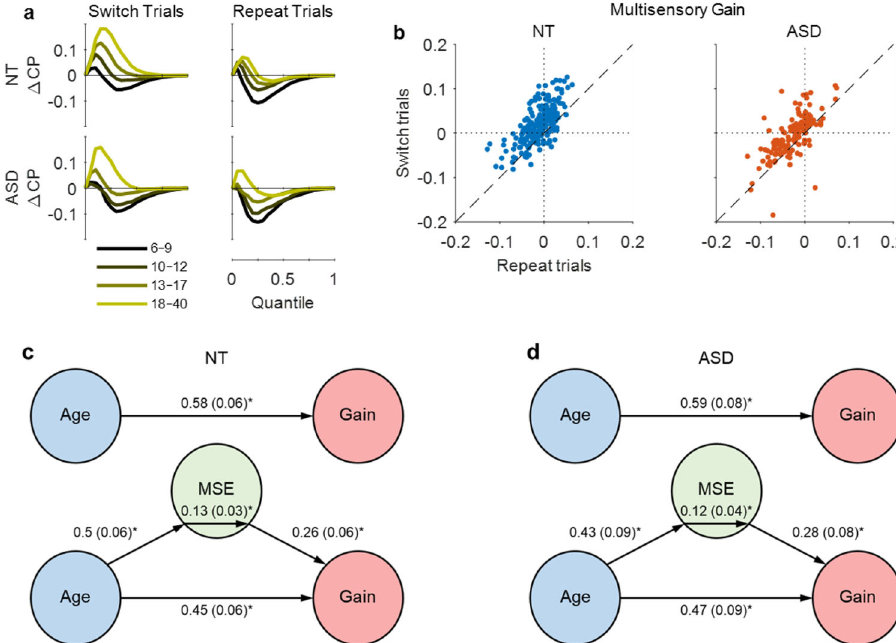
Fig. 8 Linking sequential and multisensory effects. a Race model violation by diagnosis and age for switch trials (left panel) and repeat trials (right panel). b Multisensory gain on switch trials versus repeat trials for NT (left panel) and ASD (right panel) individuals. Each datapoint represents an individual participant. c , d Mediation model that tested whether modality switch effects (MSEs) mediated the effect of age on multisensory gain. Paths between nodes are labelled with regression coef fi cients, with SE in parentheses (* p < 0.001, bootstrapped). In both groups, age predicted gain (top path), and predicted MSE controlling for gain (lower left path). The middle coef fi cients indicate formal mediation effects but the signi fi cant direct paths between age and gain controlling for MSE (bottom path) suggest only partial mediation, i.e., MSE did not explain all the shared variance between age and